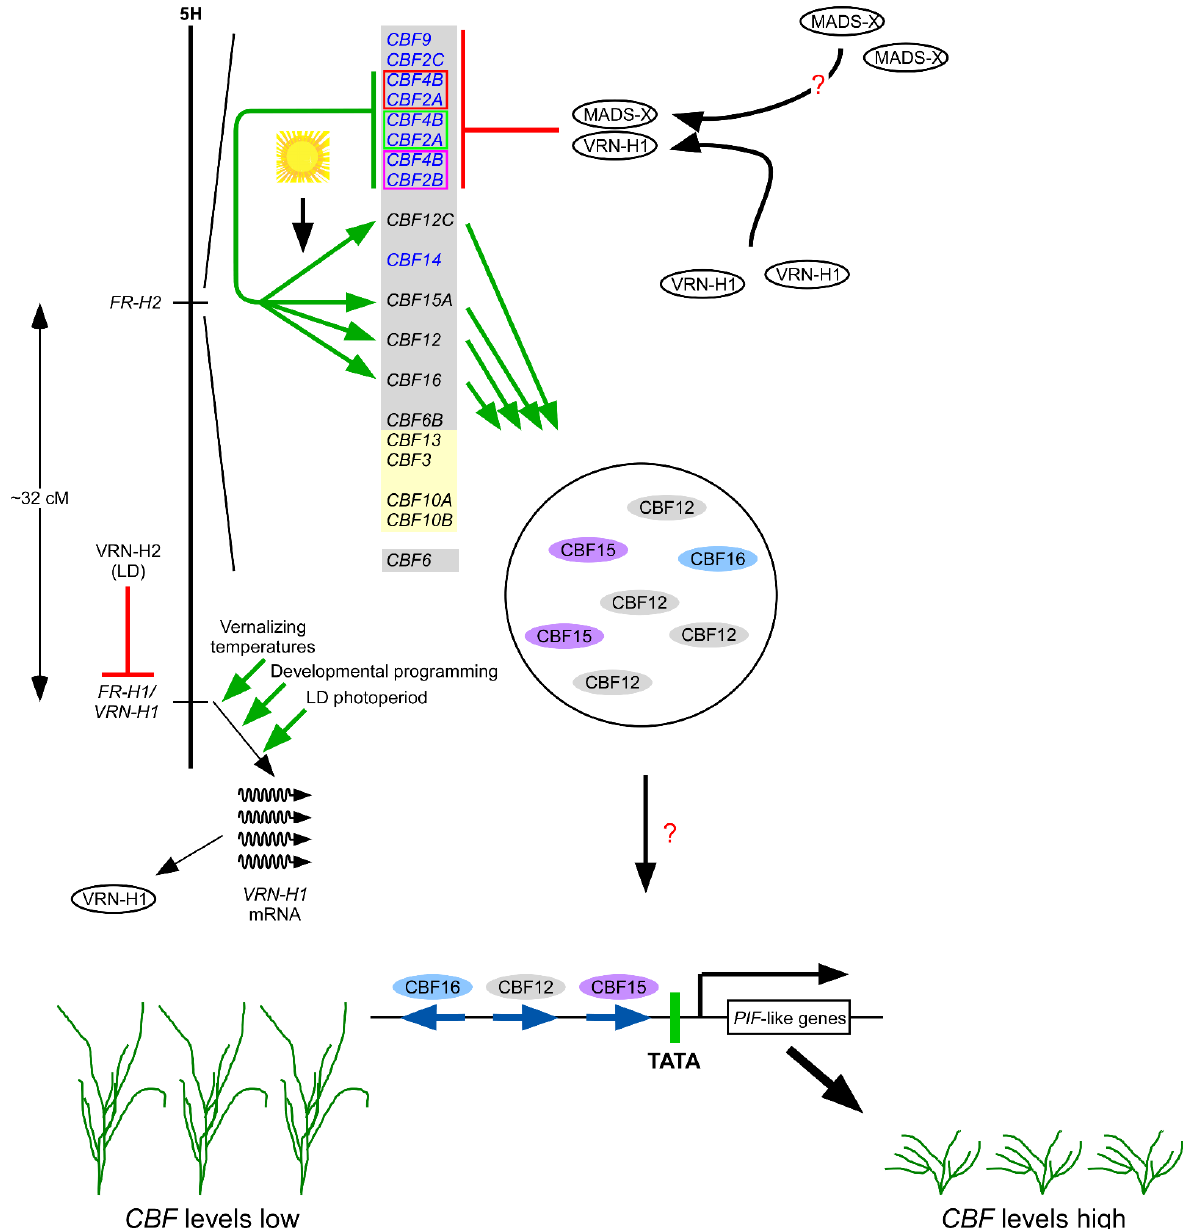
Figure 7. The genes at the FR-H1 and FR-H2 loci and the effects of their expression. This model depicts a winter vrn-H1 allele at FR-H1/VRN-H1 and the Dicktoo-Nure allele at FR-H2 , which harbors multiple copies of the CBF4B–CBF2A genomic region, boxed in red, green, and fuchsia. In the absence of VRN-H1 expression CBF s are expressed to high levels at normal growth temperatures, exhibiting circadian rhythmicity and peaking towards the latter part of the day. CBF2 [135,159] (and likely also CBF4) activate expression of the HvCBF3/CBFIIId subgroup genes CBF12 , CBF15 , and CBF16 . Increasing CBF4B–CBF2A genomic region copy numbers increases the pool of CBF12, CBF15, and CBF16. Light has a stimulatory effect upon CBF12 transcripts and may similarly affect CBF15 and CBF16 . Based on recent findings in Arabidopsis, the CBFs are hypothesized to play a role in activating PIF -like genes in the barley genome, causing growth and developmental changes associated with the prostrate growth habit and leaf length reduction. Such activity may be a specialized role of the HvCBF3/CBFIIId subgroup genes. Expression of the CBF s becomes repressed through direct binding of the MADS-box protein VRN-H1 to the CBF2 , CBF4 and CBF9 genomic regions. This may occur in conjunction with an as yet unidentified MADS-box protein that forms a heterodimer with VRN-H1, a mechanism typical of MADS box proteins. A spring Vrn-H1 allele at VRN-H1 results in constitutive expression of VRN-H1 and the constitutive repression of FR-H2 . The winter vrn-H1 allele restricts VRN-H1 transcript accumulation until other endogenous signals or external cues trigger its accumulation, the latter of which can be prolonged exposure to cold, LD photoperiod, or both, depending on the genotype. VRN-H2